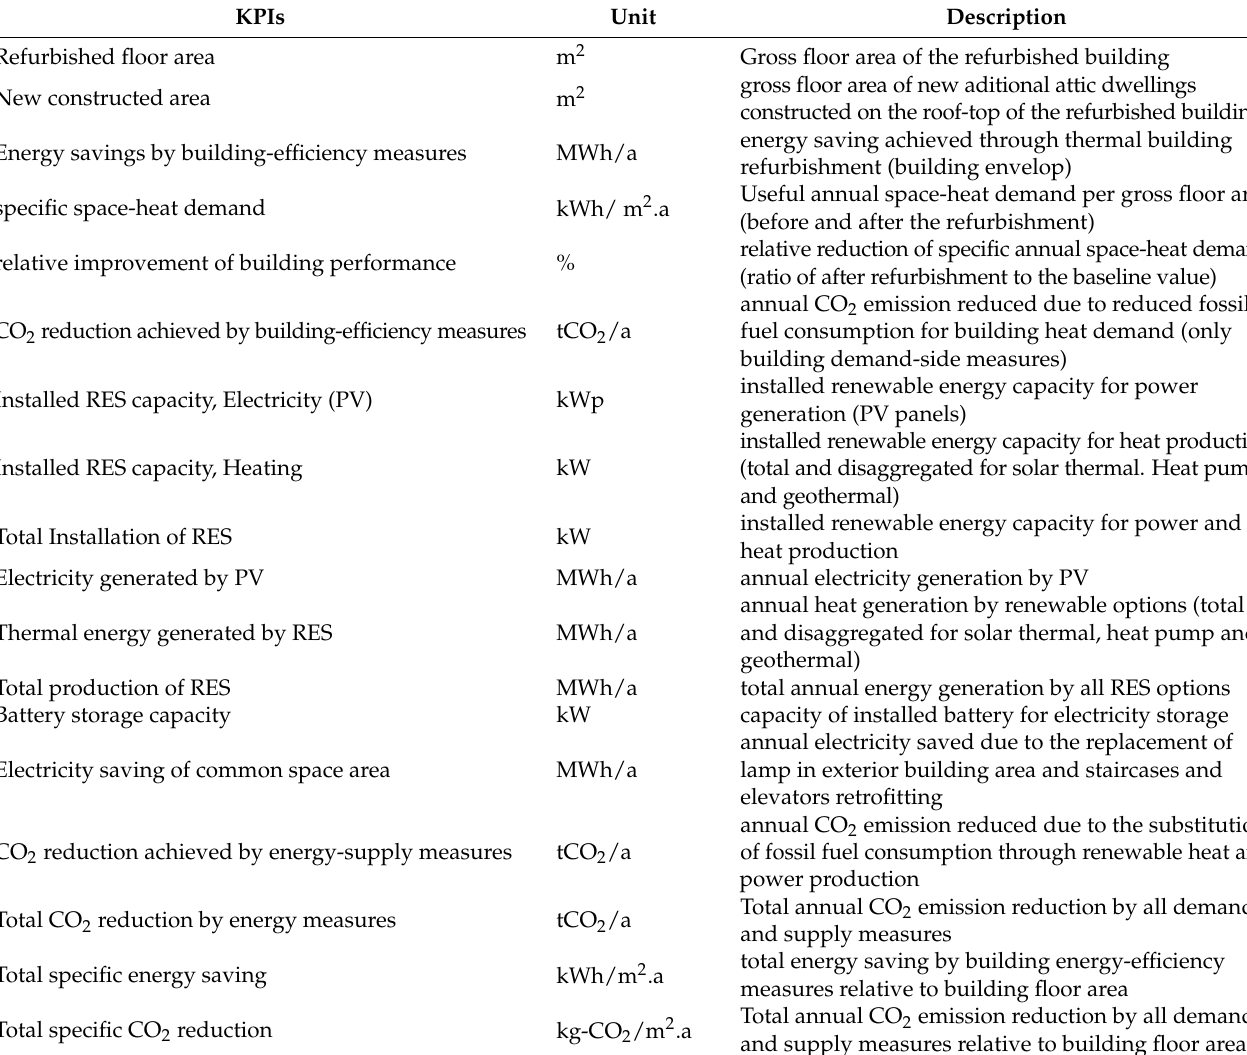
Table 3. List of the extracted KPIs to evaluate the impact of building energy solutions for low-energy districts in the Smarter Together